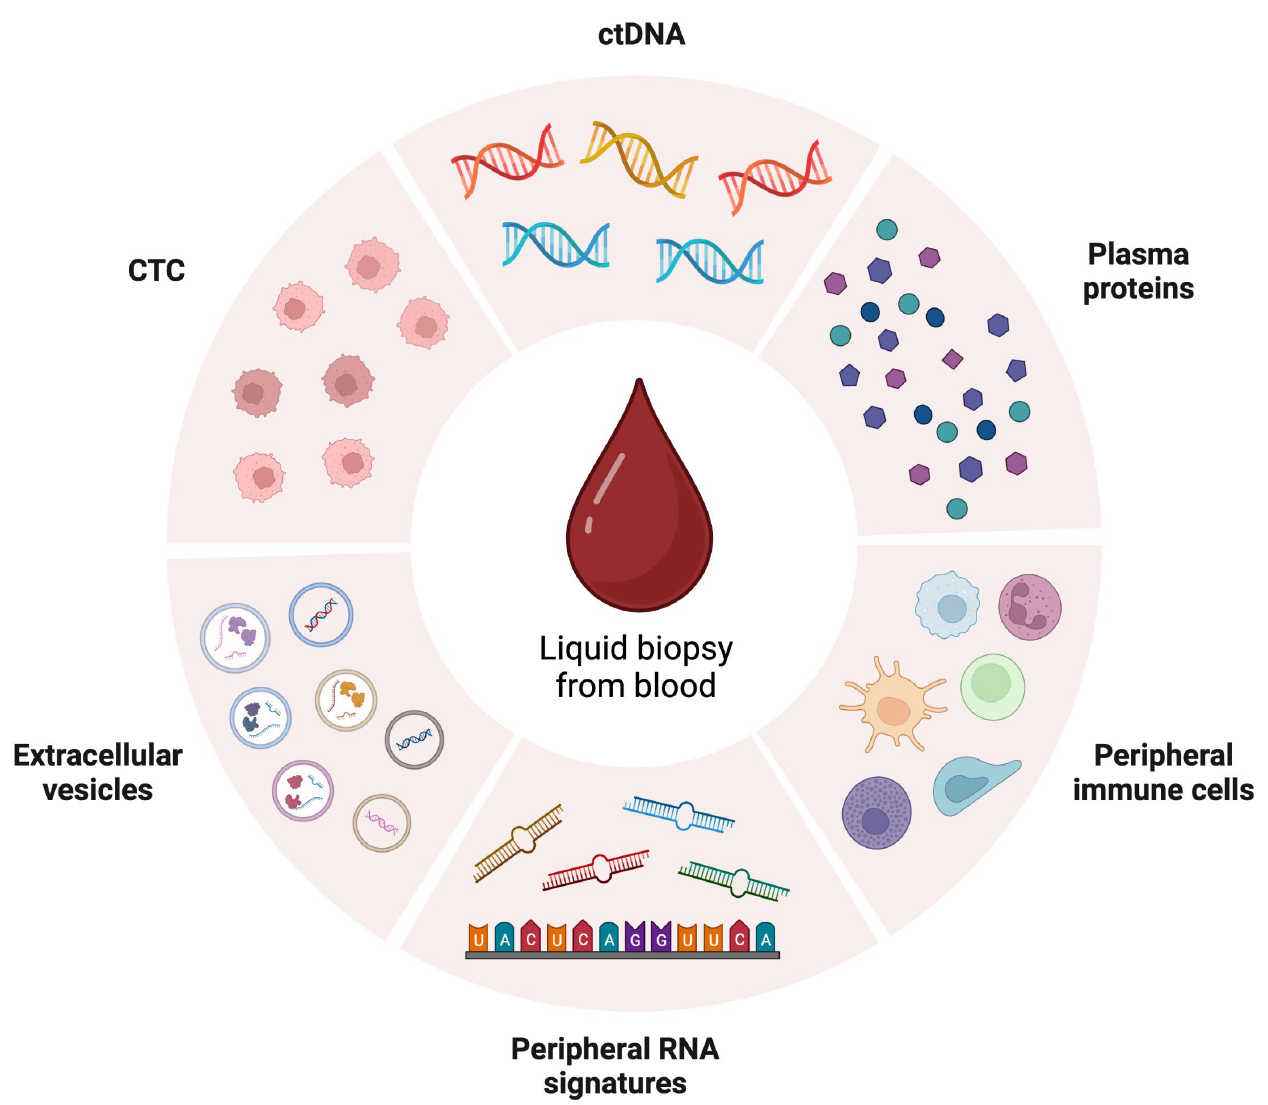
Figure 1. Circulating analytes present in the peripheral blood that are used for liquid biopsy. The image was created with BioRender.com. Abbreviations: CTC, circulating tumor cells; ctDNA, cir- culating tumor DNA.